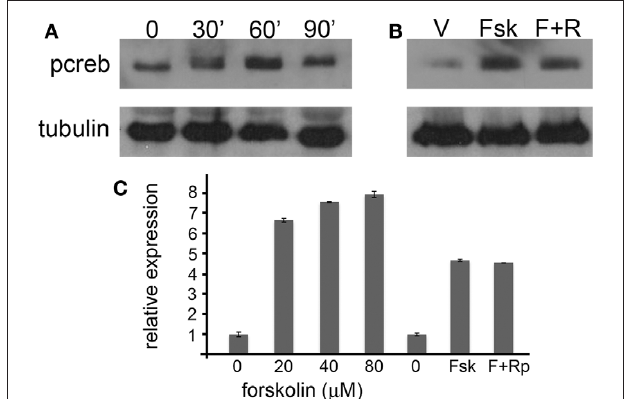
Figure 8 | Pcdh10 expression is regulated by cAMP in explants. (A) Ex vivo culture of explants treated with 20 μM forskolin for 0, 30, 60, and 90 min results in a transient increase in phosphocreb signal. (B) Pretreatment of explants with 40 μM RpcAMPs overnight prior to addition of forskolin (20 μM; 1 h) reduces phosphocreb. (C) Representative qRT-PCR showing forskolin (20–80 μM) can induce the expression of pcdh10 in explants relative to vehicle (DMSO) alone. Induction of pcdh10 expression is not blocked by pretreatment